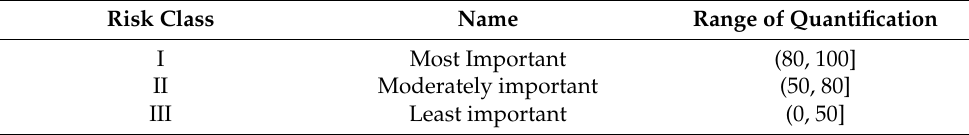
Table 5. Quantification table of importance grading of each